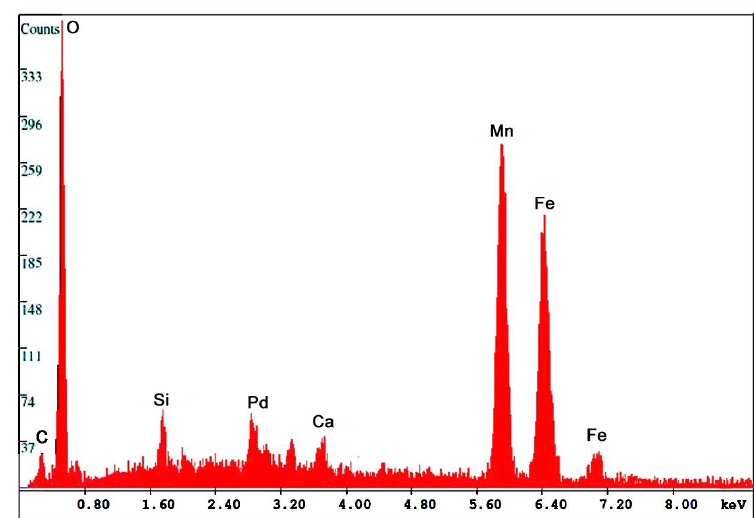
Figure 13. SEM/EDS spectrum for Fe-Mn oxide fossil wood from Virgin Valley, Nevada, USA. Table 5. SEM/EDS data for Mn-Fe oxide fossil wood from Virgin Valley, Nevada, USA.